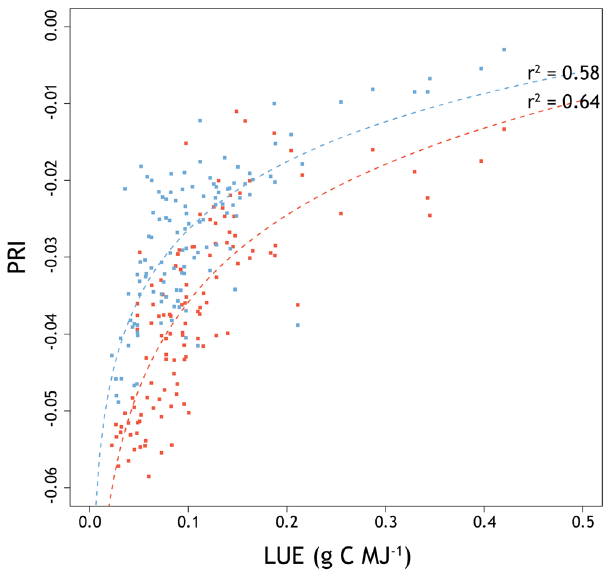
Figure 5. Daily relationship between BRDF-corrected PRI and LUE at the hotspot (red) and darkspot (blue), with logarithmic best fit